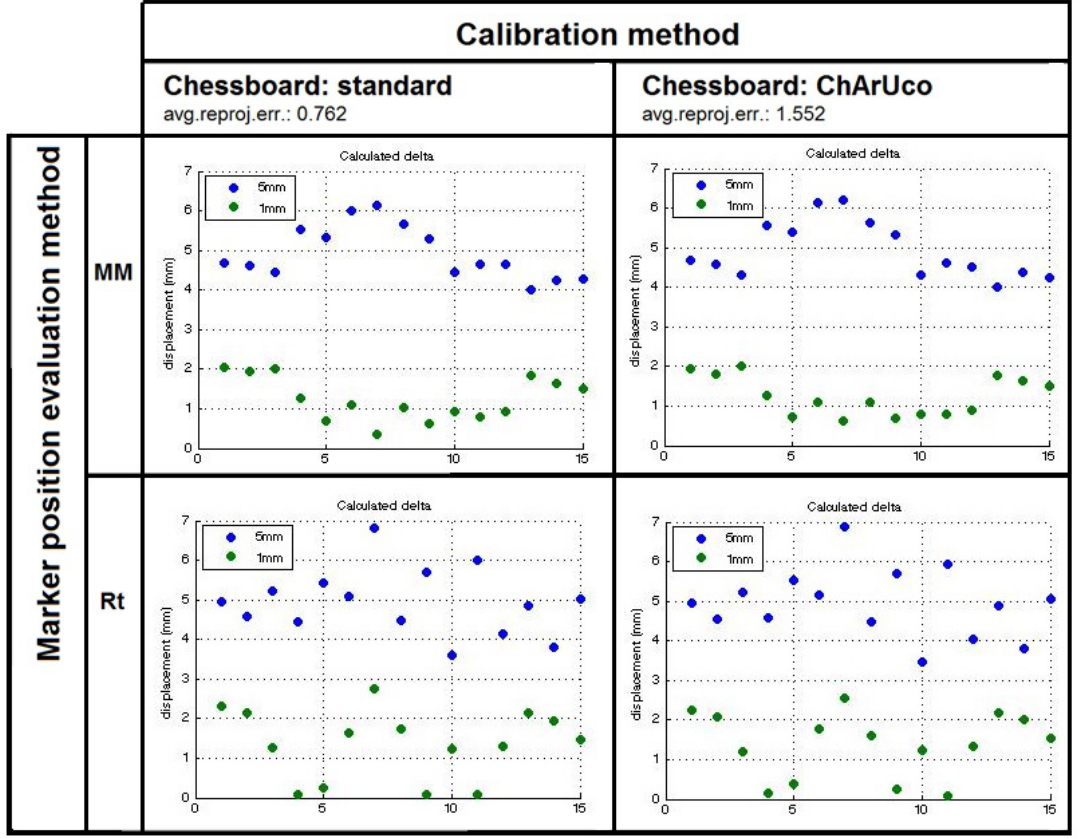
Figure 4. Scatter plot of the distance variations ( ∆ = 5 mm and ∆ = 1 mm) evaluated using two methods: (MM) the SLAM as in [17]; (Rt) computing the 3D translation vectors directly from the camera pose parameters. In both cases, the two methods were run using two sets of camera calibration parameters computed by using the standard chessboard and the ChArUco